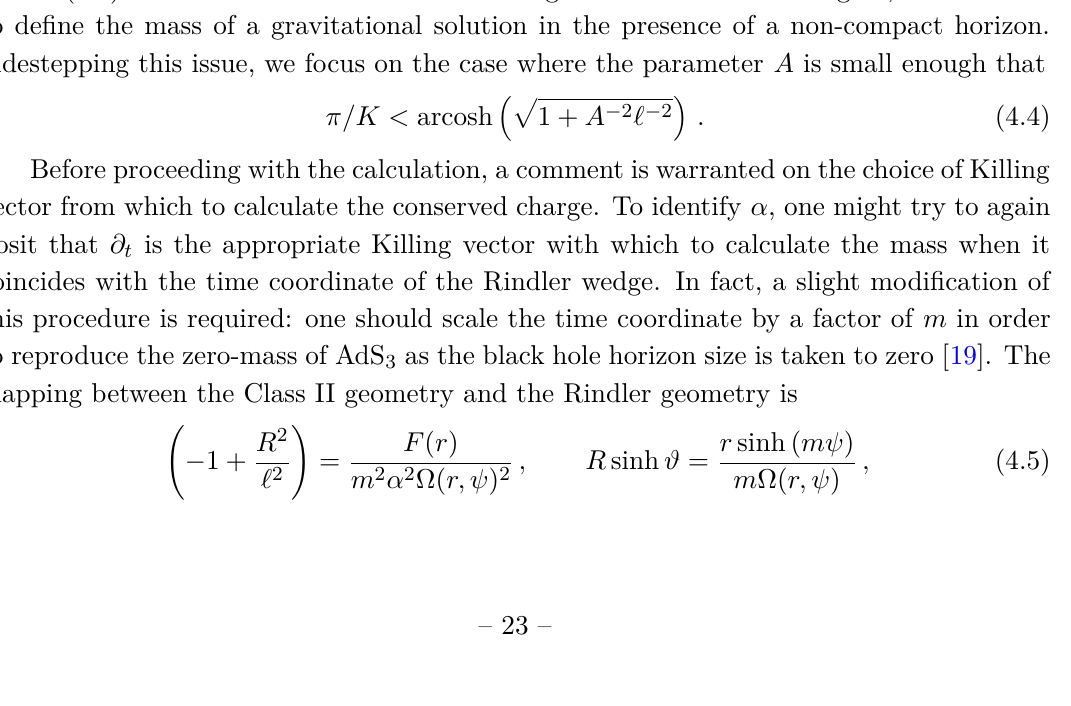
JHEP05(2022)063